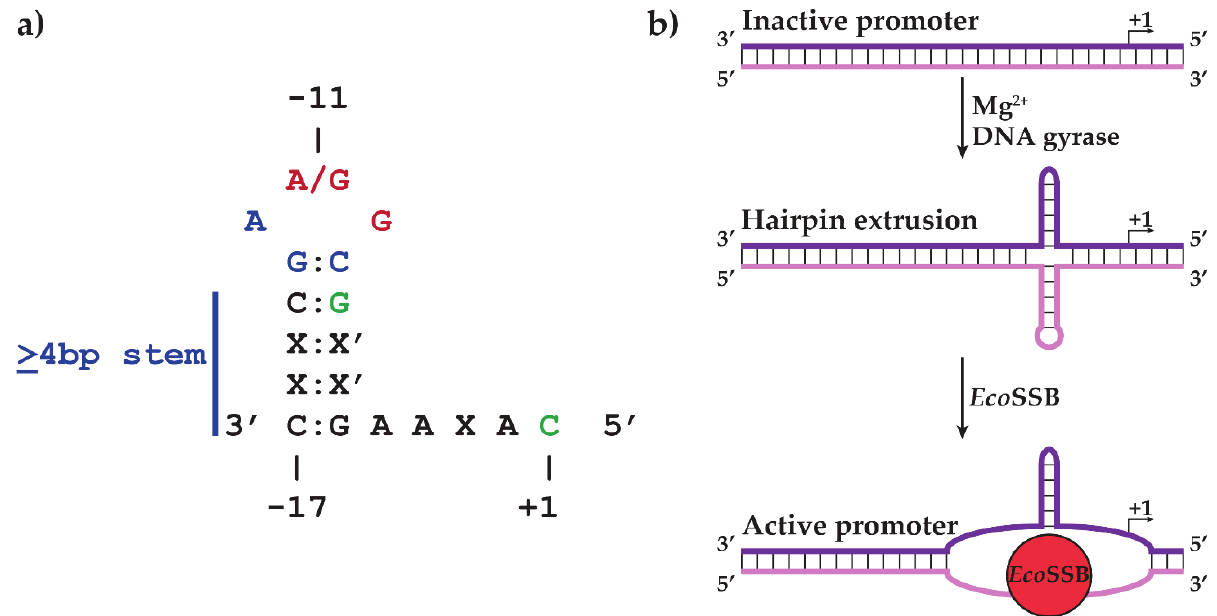
Figure 2. ( a ) Summary of sequence requirements for early promoter hairpin-extrusion (blue), vRNAP binding (green), and both processes (red) as determined by hairpin extrusion probing and runoff transcription experiments. Template strand sequences are shown relative to the transcription start site (+1) in 3' to 5' orientation. ( b ) Model of early promoter activation. N4 genomic DNA is injected into the host cytoplasm in an inactive linear double-stranded conformation. Introduction of negative supercoils by DNA gyrase induces the extrusion of the promoter hairpin in a Mg 2+ - and sequence-dependent manner. Subsequent binding of Eco SSB leads to melting of the non-template strand hairpin and stabilization of the template strand hairpin to provide the active promoter conformation required for vRNAP binding. Template and non-template strands of promoter DNA are represented as purple and pink,